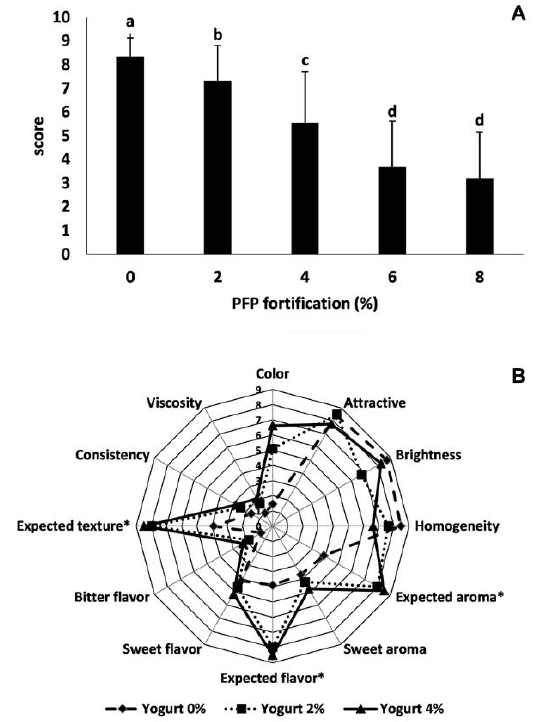
Figure 1. Sensory acceptance ( A ) and sensory profile ( B ) of passion fruit drinkable yogurts. Different lowercase letters ( A ) indicate that treatments differ significantly ( p < 0.05). PFF: passion fruit peel and seeds flour. *When compared to a passion fruit-based yogurt.